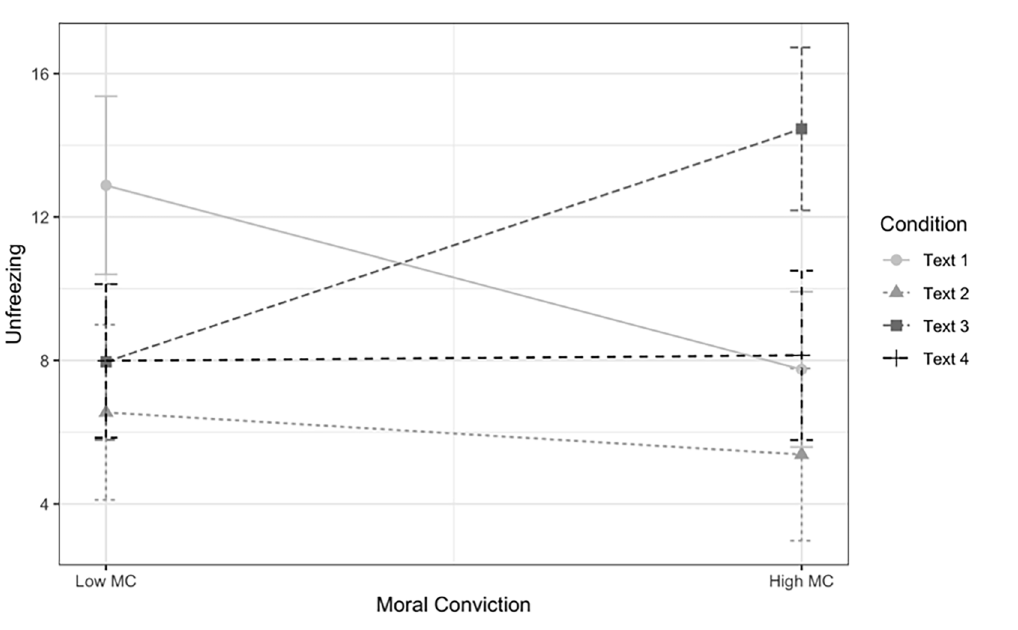
Figure 4. The interactive effect of condition and moral conviction on unfreezing. Note. Error bars represent SE